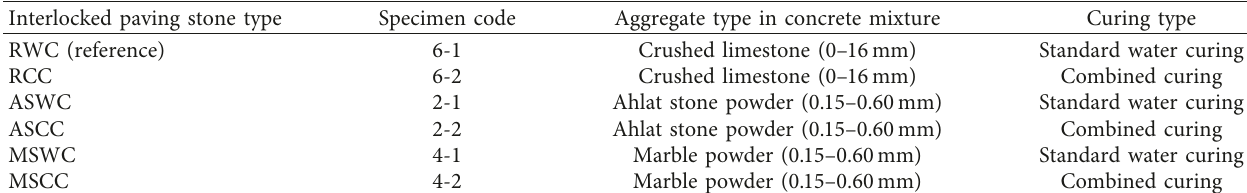
Table 15: Code, aggregate type, and curing type for the interlocked paving